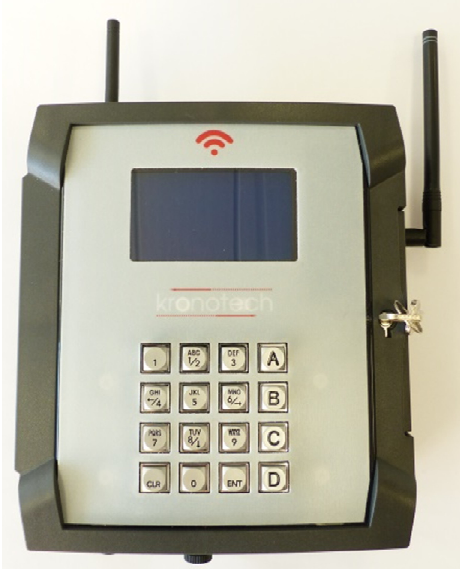
Figure 2. The Central Unit is able to manage up to six intravaginal devices. The Unit is composed of a screen, a keyboard and an internal housing which contains the circuit board, the slot for the cell phone Sim Card and a battery. To activate the probe, this is placed with the “magnet side” toward the red symbol .